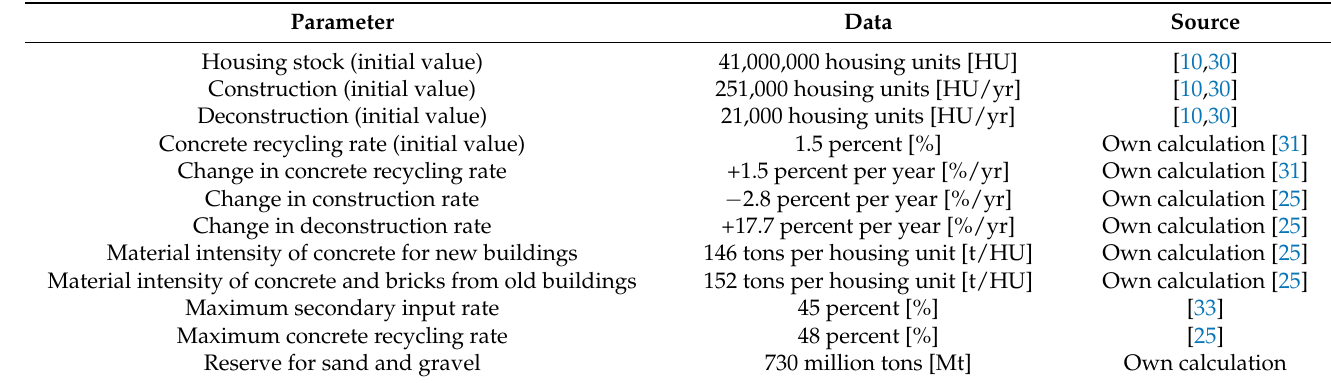
Table 1. Parameter, data and data source used for the modelling and